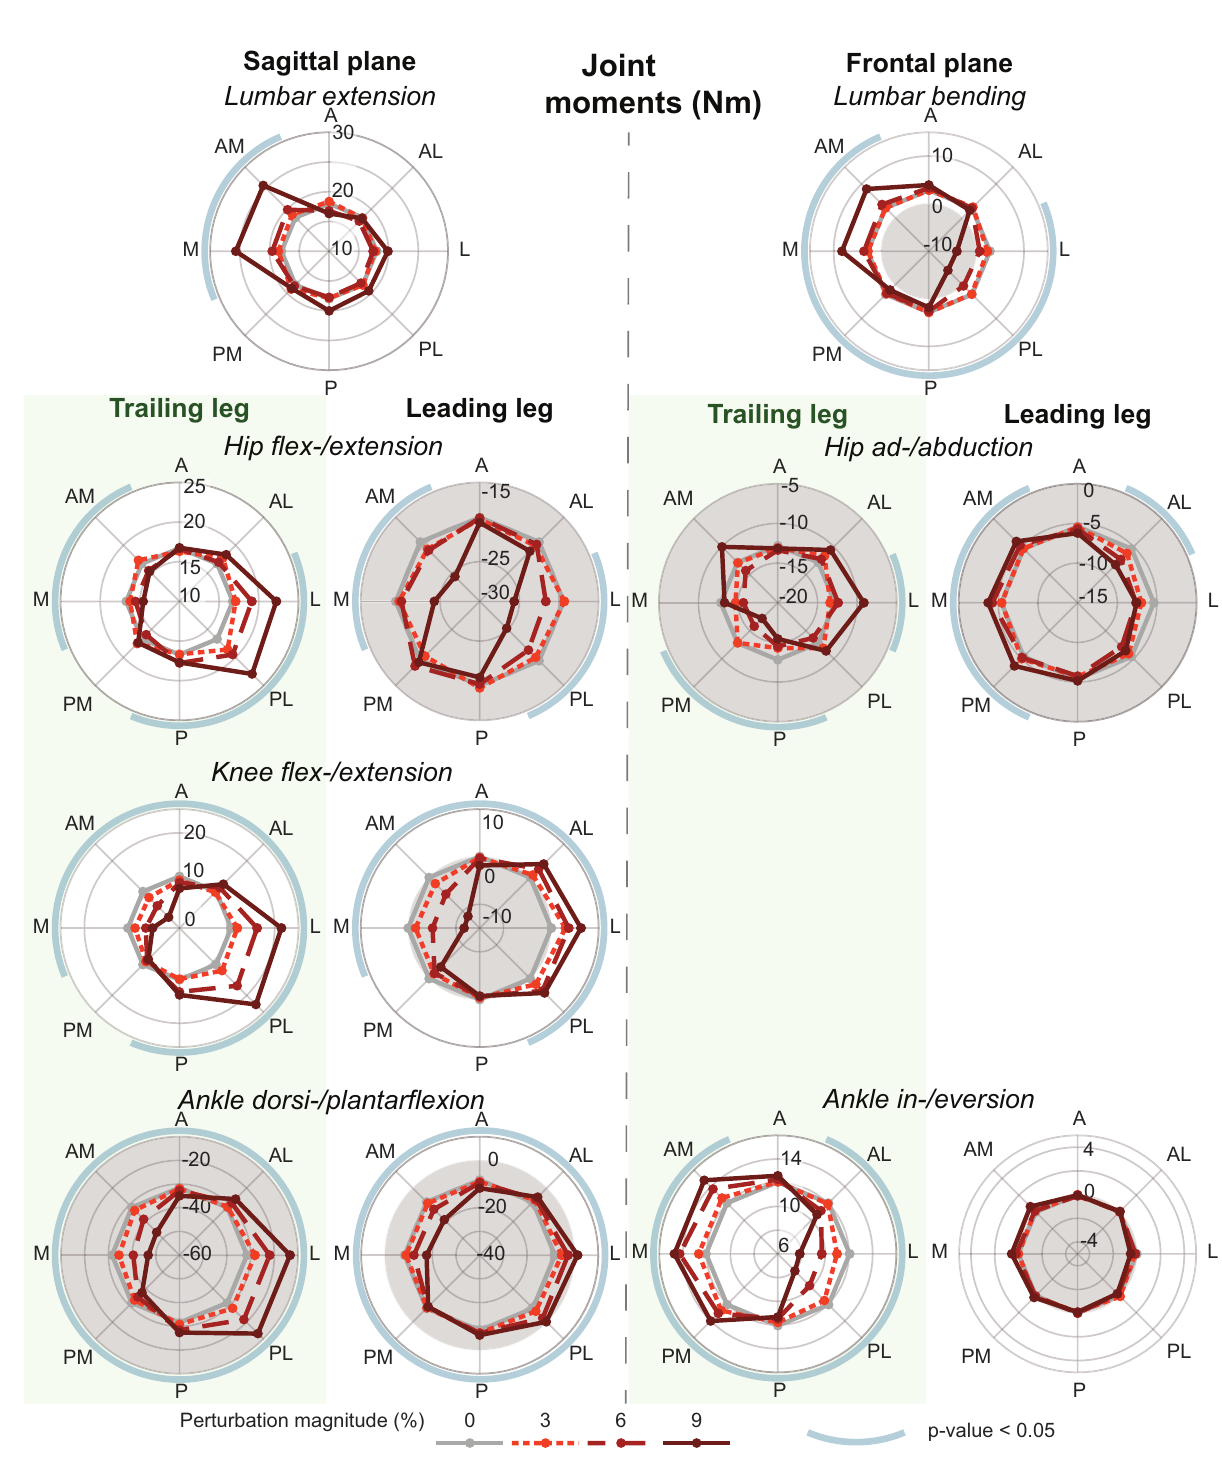
Fig 5. Joint moments. Joint moments of the lumbar, hip, knee and ankle joint in the frontal and sagittal plane in Nm. The mean value over the first 1.5 s, is shown for each perturbation magnitude and direction and the baseline during standing in the staggered stance posture. The line colour and style indicate the perturbation magnitudes. The blue circular arcs around the polar plots indicate whether there is a significant effect of the perturbation on the outcome measure with p < 0.05. The gray background indicates a negative value. All results are based on the averages across all